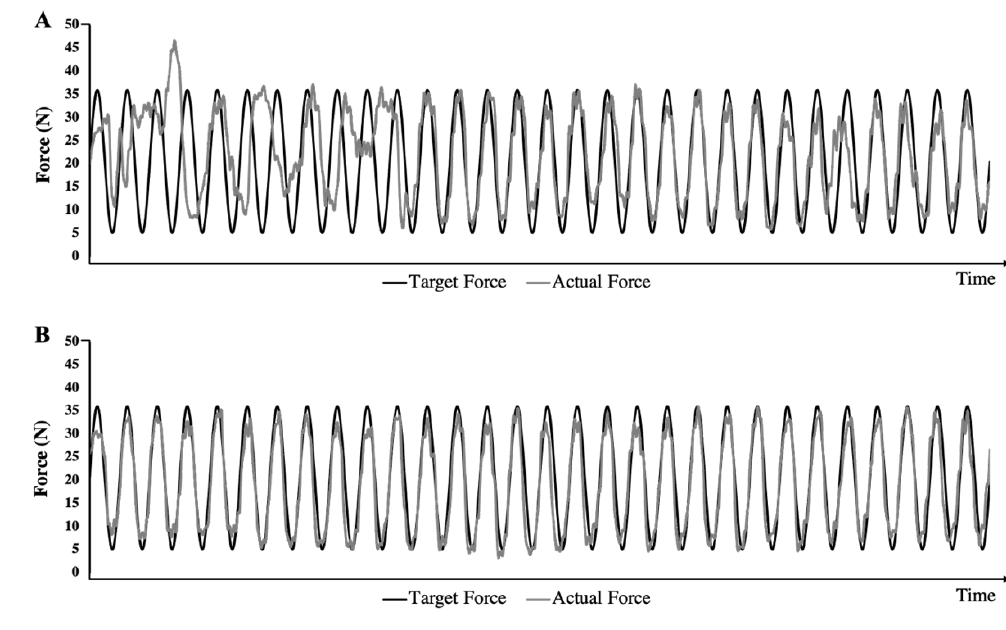
Figure 2. Representative precision grip task (PGT) trials illustrate the significant decline in force error that occurred between the two conditions. For this representative participant, the reduction in force error was 4.22 N between these two trials. ( A ) The force time profile for a single trial performed in the Baseline condition. ( B ) The force time profile for a single trial performed in the Experimental